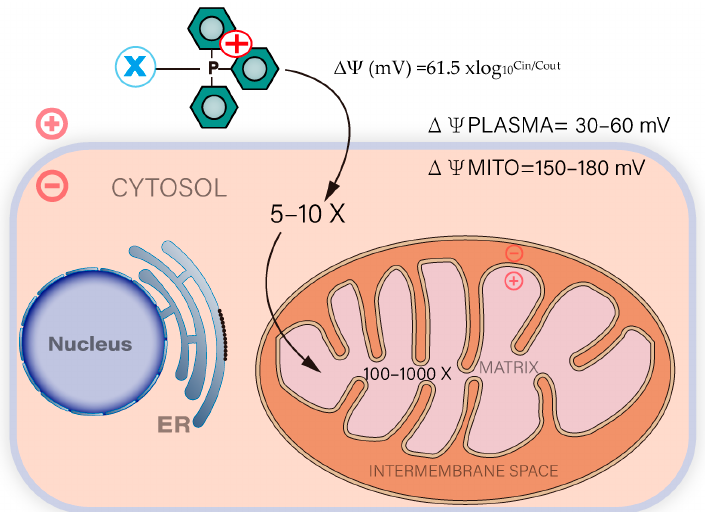
Figure 2. Cellular uptake of TPP conjugated compounds driven by plasma and mitochondrial mem- brane potentials. Compounds containing TPP can be rapidly absorbed by mitochondria driven by high mitochondrial membrane potential. At equilibrium, the ion concentrations on both sides of the charged membrane can be described by the following equation: ΔΨ (mV) = 61.5 × log 10Cin/Cout